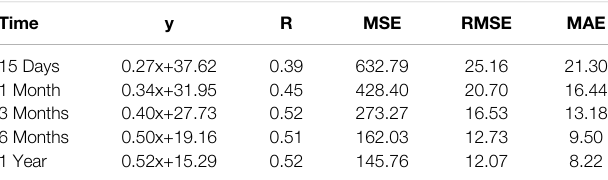
TABLE 2 | PM 2.5 2020 model performance statistics with different time period in Jiangsu Province.